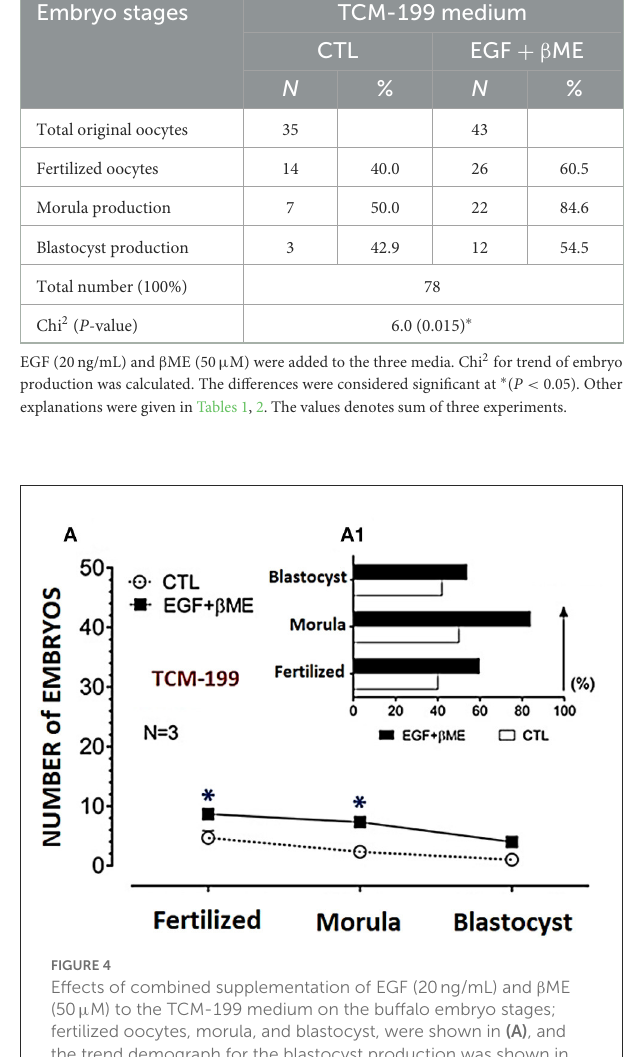
the combined supplementation of EGF plus β ME, and then β ME compared with each respective control (33.9 vs. 3.6, 27.9 vs. 8.6, and 18.4 vs. 3.1%, respectively; Tables 1–3 and Figures 3,